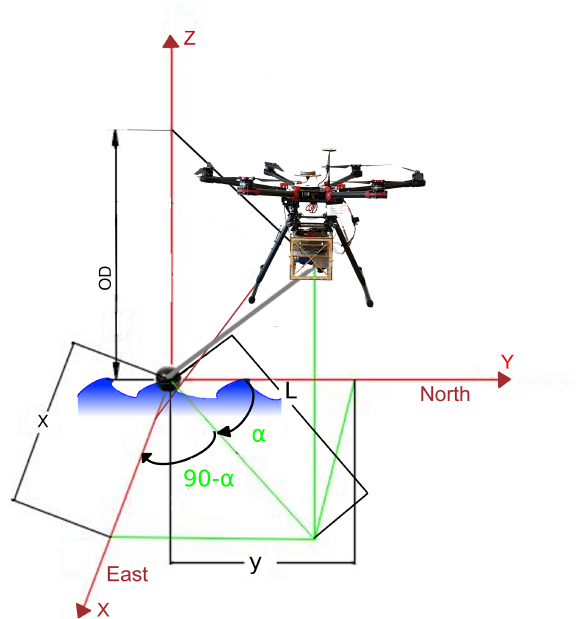
Figure 3. Sonar is the center of the reference system X , Y , Z . The horizontal displacement between the sonar and the drone is com- puted along the X and Y directions, while the vertical displacement is computed along the Z axis (object distance – OD). The angle α is the azimuth, i.e., the angle between the Y axis pointing north and the vector between the drone and the sonar, projected onto the hor- izontal plane (in green). The azimuth angle is measured clockwise from north (i.e., α is positive in the